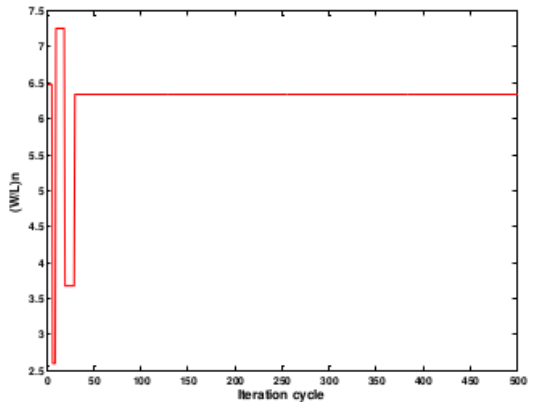
Figure 10: Box and whisker plots of RGA for the second design set of Case study-1 over 50 trial runs.